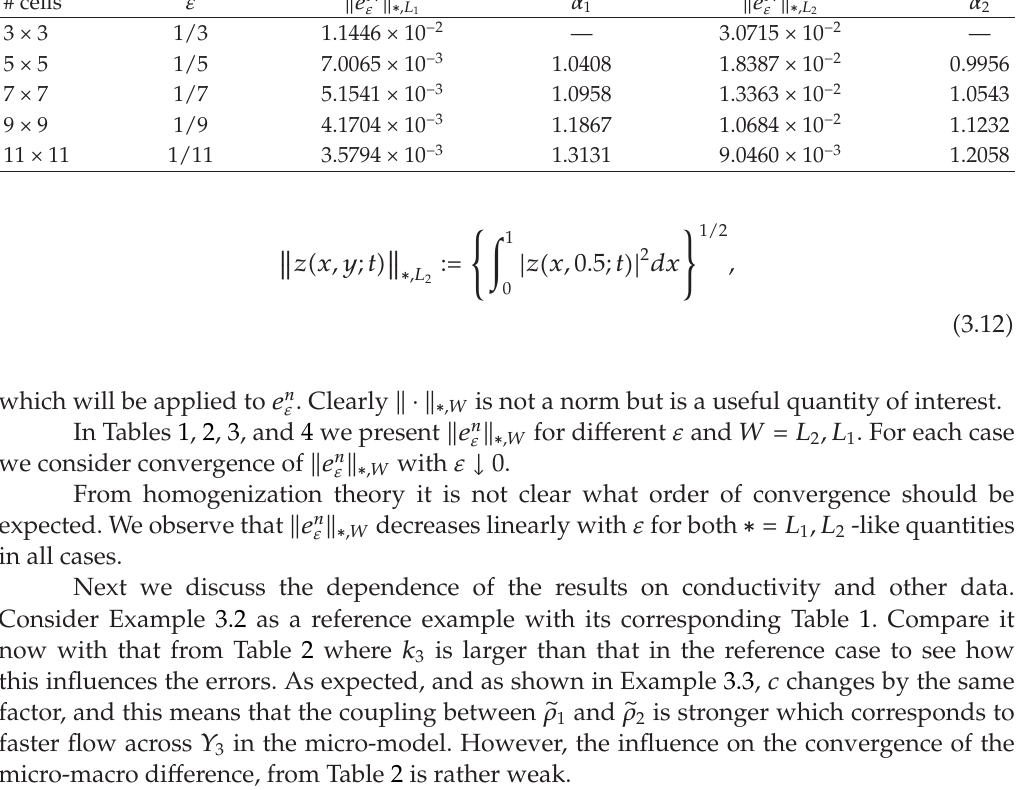
Table 2: Comparison of the macro-model to the micro-model for di ff erent values of ε as in Example 3.3. #